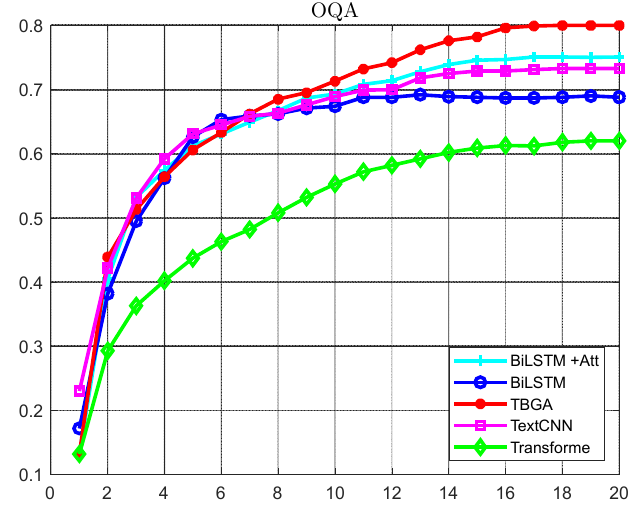
Figure 9. Comparison of accuracy rates on the OQA verification set.